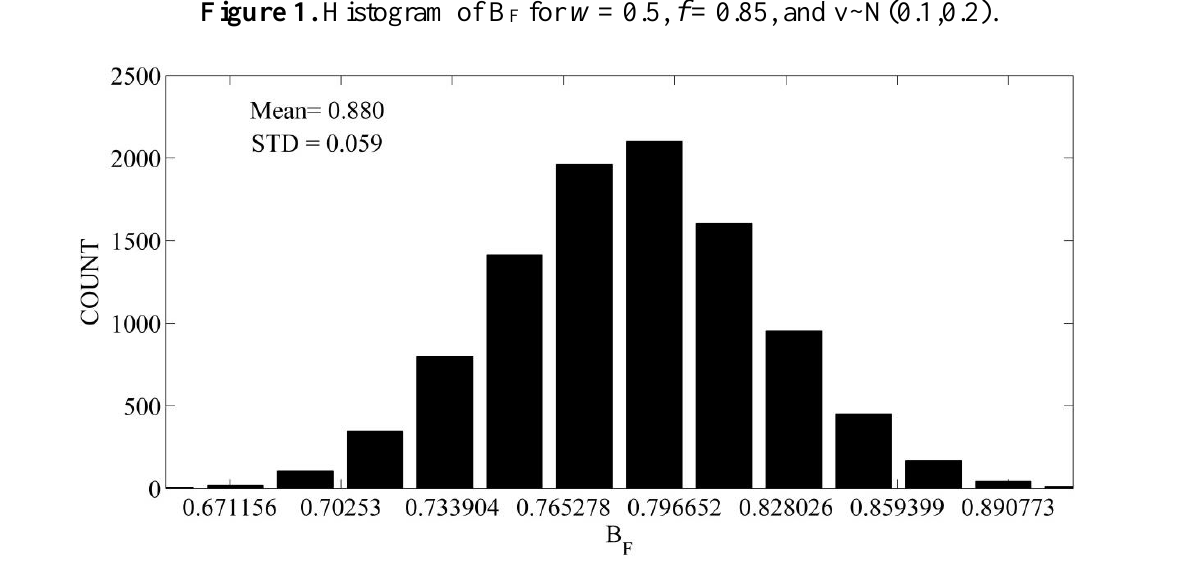
Figure 1. Histogram of B F for w = 0.5, f = 0.85, and